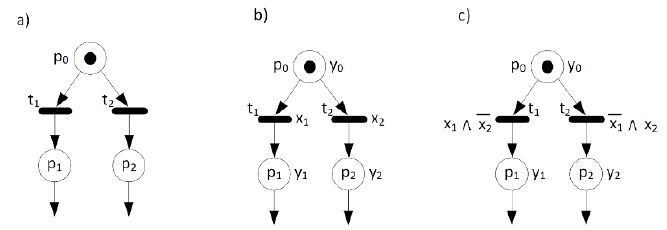
Figure 1. A sample Petri net without guarded transitions ( a ), with guarded transitions ( b ) and with mutually exclusive guarded transitions ( c ).